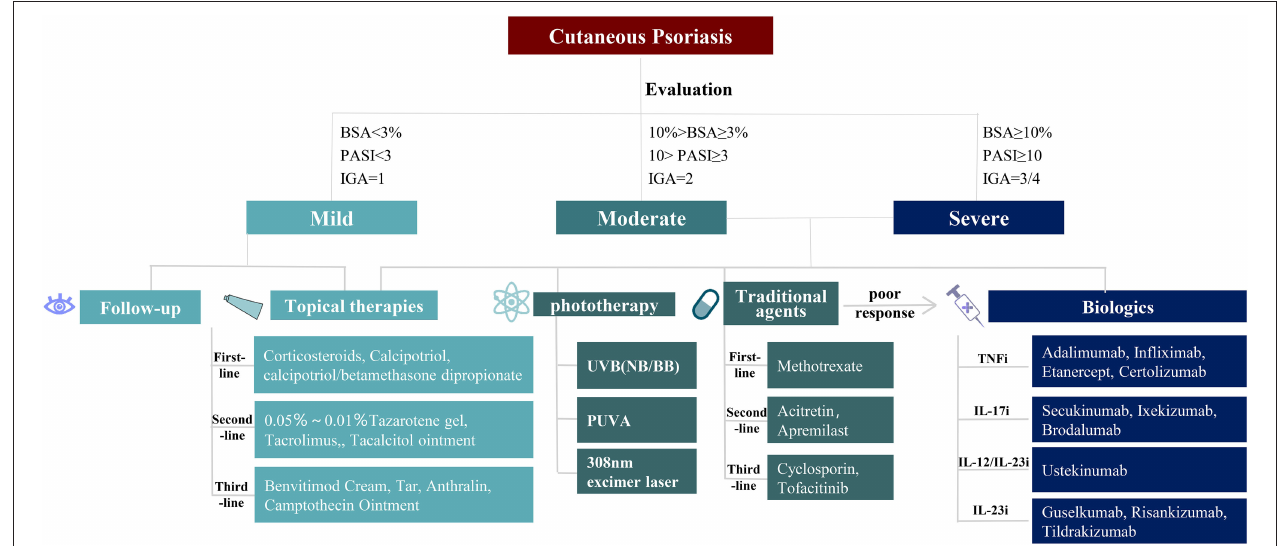
FIGURE 1 | Therapies for cutaneous psoriasis. Different treatments for mild, moderate, and severe patients with cutaneous psoriasis. For mild cutaneous psoriasis, follow-up and topical therapies are advised choice. For moderate to severe cutaneous psoriasis, topical therapies, phototherapy, traditional agents, and biologics can be selected one by one. BSA , body surface area; PASI , psoriasis area and severity index; IGA , investigator’s global assessment; UVB , ultraviolet radiation b; NB , narrow bound; BB , broad bound; PUVA , psoralen plus ultraviolet radiation a.